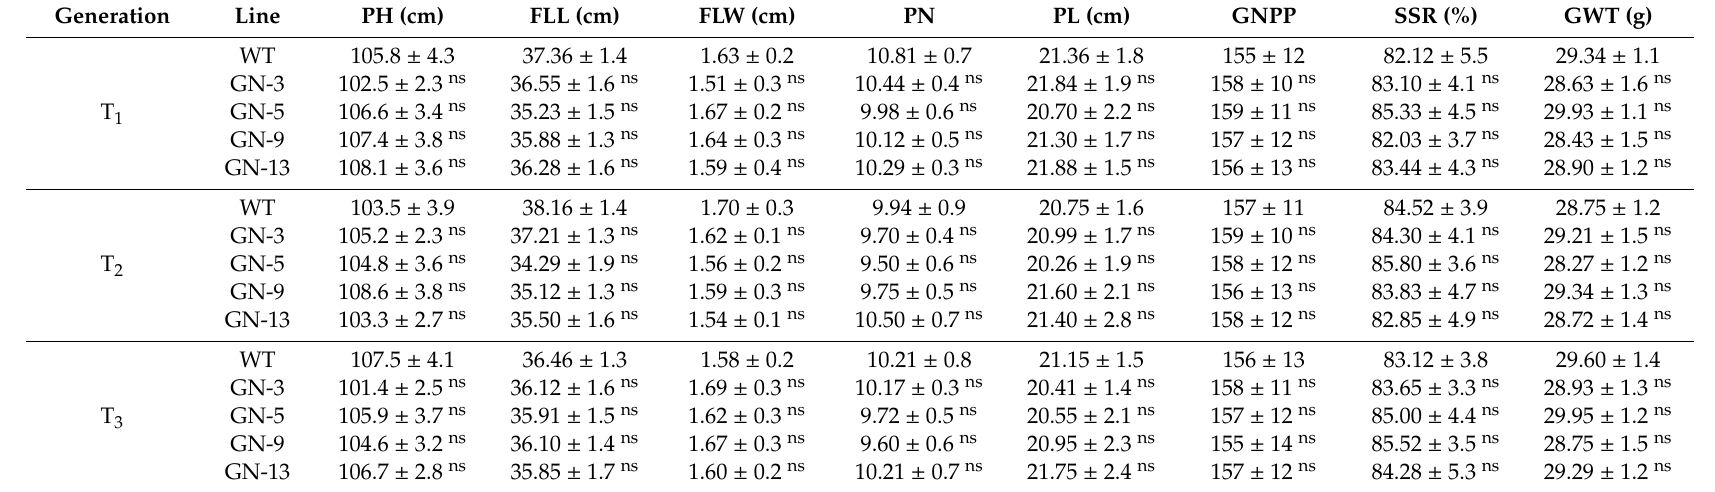
Table 2. Performance of wild type and homozygous mutant plants for main agronomic traits in T 1 , T 2 , and T 3 generations.